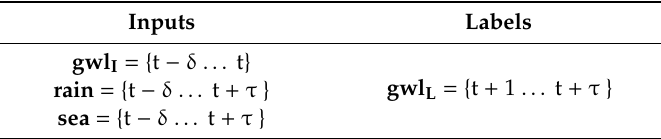
Table 3. Input and label tensors for neural network